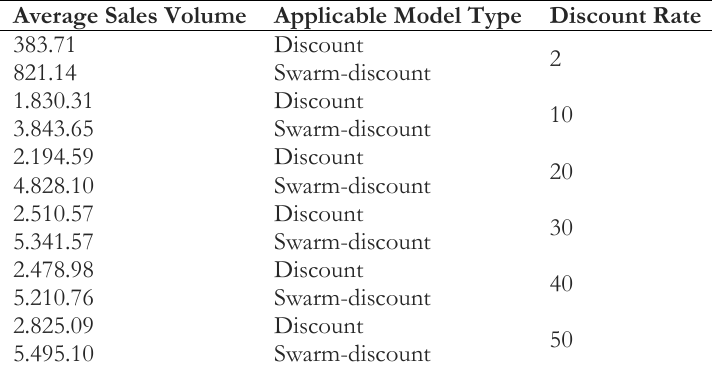
Table 6. Average sales volume by implementing discount and swarm-discount model (source: research-findings).